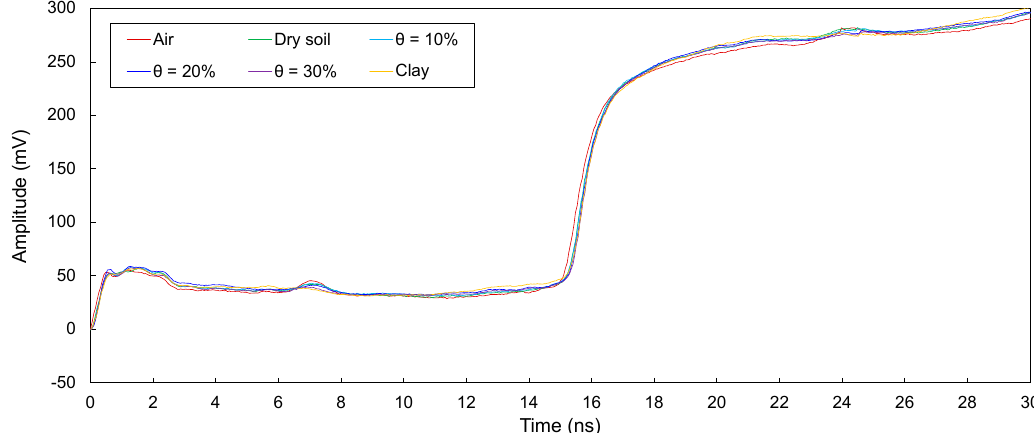
Figure 11. Measured signals for D4 with the defect filled with different materials of air; dry sand; wet sands with θ = 10%, 20%, and 30%; and clay.